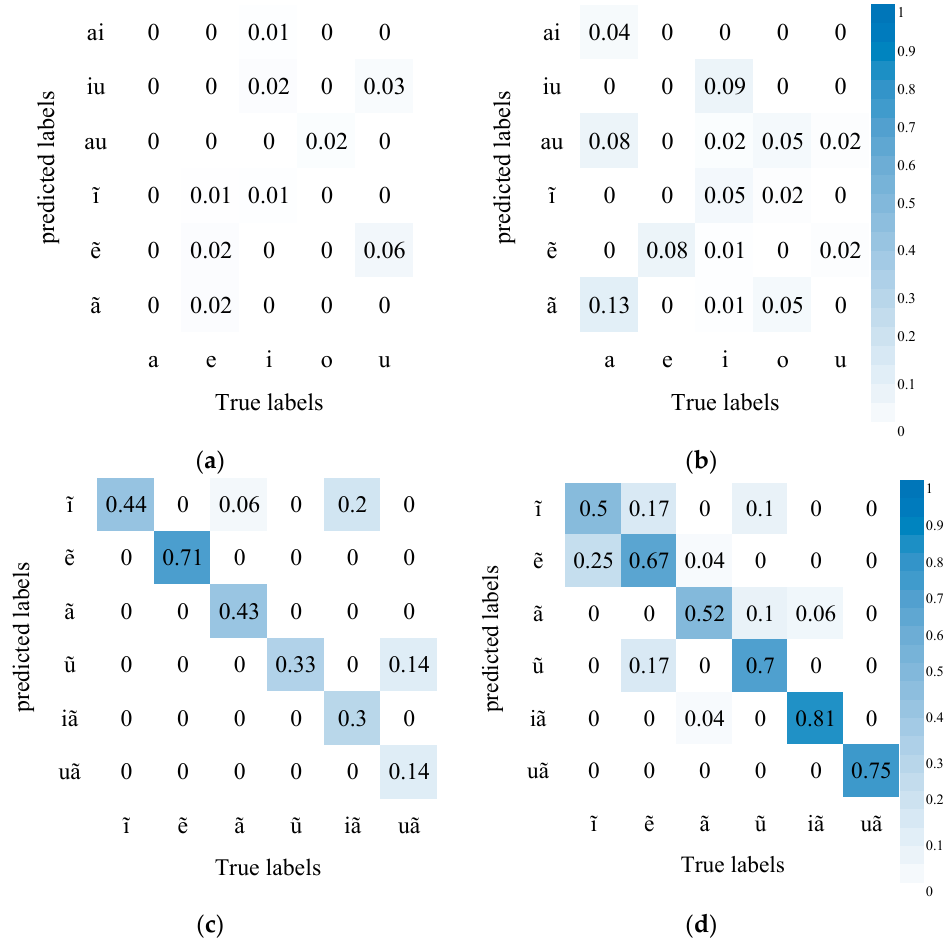
Figure 6. AVSR performance in recognizing finals: ( a ) Simple Finals and other finals Confusion ma- trix of AVSR; ( b ) Simple Finals and other finals Confusion matrix of ASR; ( c ) nasal vowels Confusion matrix of AVSR; ( d ) nasal vowels Confusion matrix of ASR.